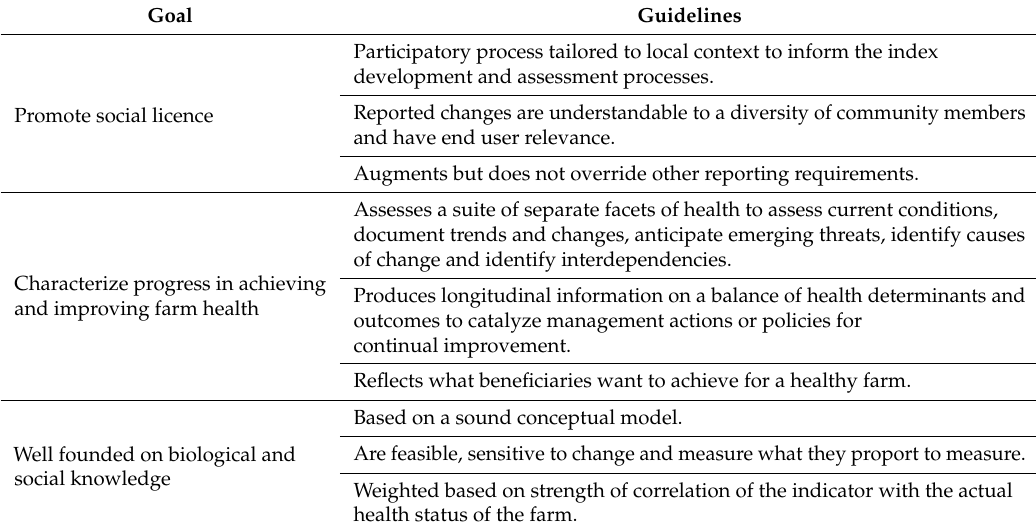
Table 2. Goals and guidelines informing the development of a conceptual model of an aquaculture well-being